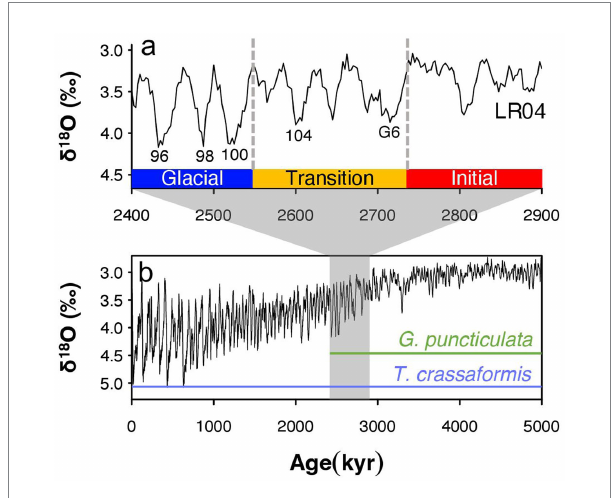
FIGURE 2 Benthic oxygen isotopes from the Lisiecki and Raymo global benthic stack (Lisiecki and Raymo, 2005) in (A) our study interval (B) and the past 5 million years (Lisiecki and Raymo, 2005). Climate phases are characterized by a transition to 41-kyr glacial cycles (Transition Phase) and increasing glacial intensity (Glacial Phase). Key Marine Isotope Stages and the temporal ranges of the study species Globoconella puncticulata and Truncorotalia crassaformis are indicated as well. Note that 𝛿 18 O values are inverted, with highest values meaning lowest temperatures and/or largest polar ice sheets.